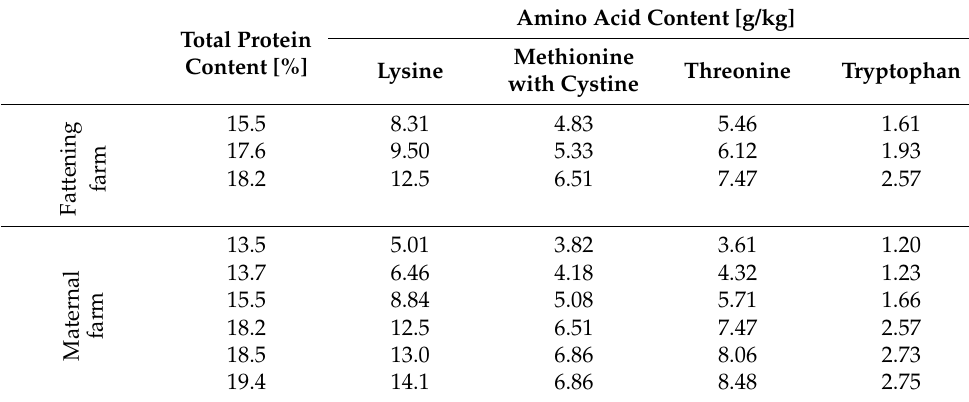
Table 1. The content of amino acids in the feed mixtures from individual pig